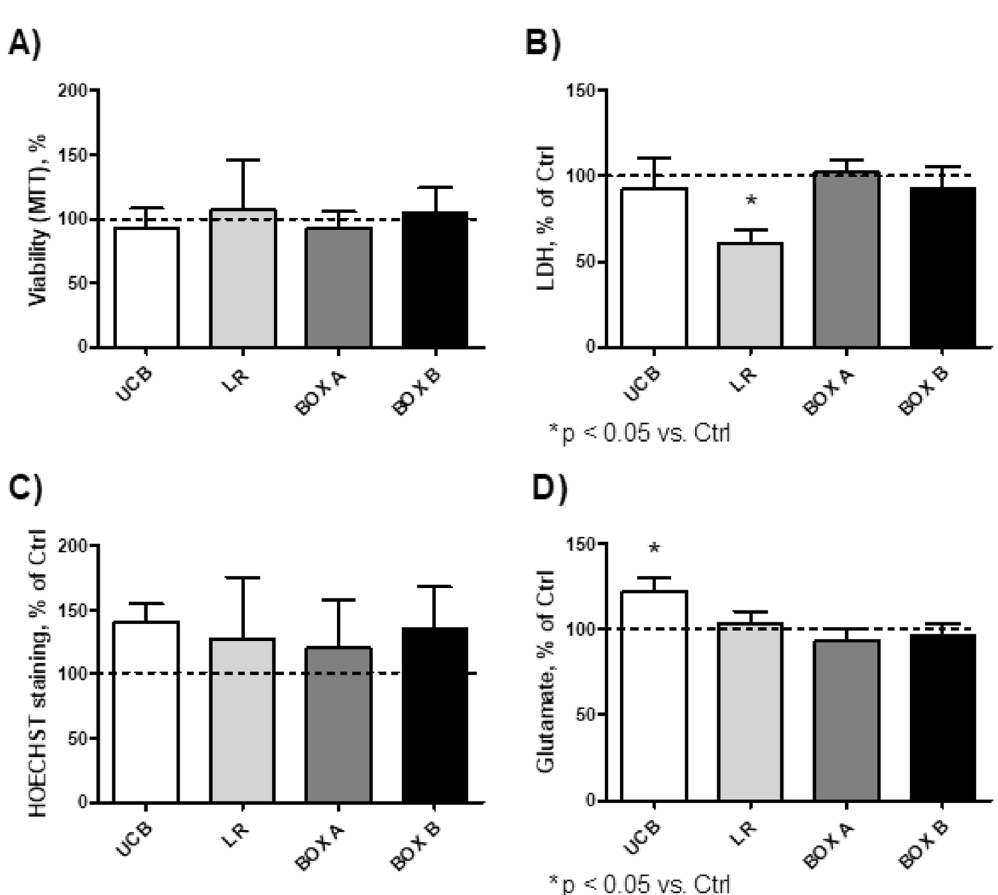
Figure 2. Viability of organotypic rat hippocampal slices after 4 h of exposure to UCB, LR, BOX A, or BOX B. Cell viability was evaluated by MTT assay ( A ), LDH release ( B ), HOECHST staining ( C ), and glutamate release ( D ). The values acquired for control cells were used to define 100% level. Concentrations of tested compounds = 25 μ